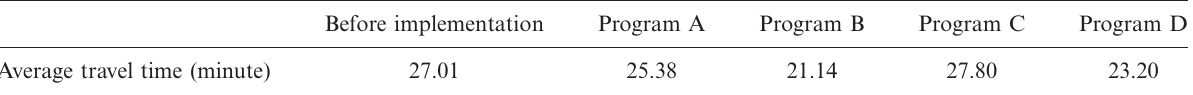
Table 10. Travel duration analysis of the integrated programs